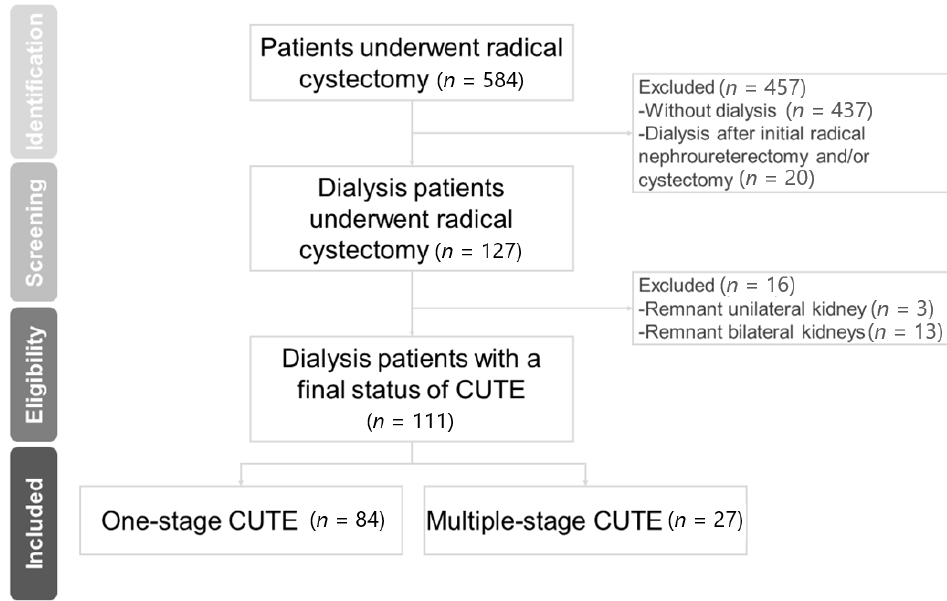
Figure 1. Patient enrollment flowchart. CUTE, complete urinary tract extirpation. Table 1. Characteristics of dialysis patients undergoing